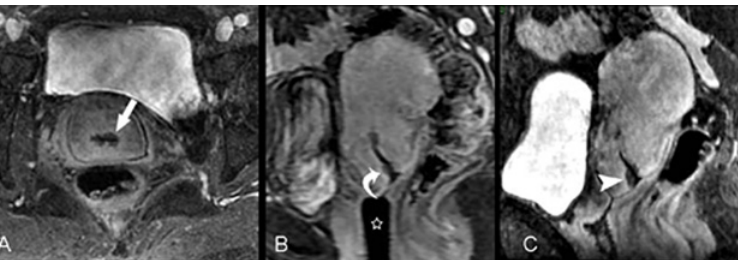
Fig 2. F48, poorly differentiated squamous cell carcinoma (stage IB1). Contrast-enhanced axial isotropic sequence (A) shows a low signal lesion around the cervical canal (arrow); the signal is lower than that of the surrounding cervical stroma and the greatest depth is approximately 4.4 mm. Directly acquired contrast- enhanced sagittal images (B) show a suspicious low signal lesion in the cervical canal close to the external os of the uterus (curved arrow). An OB tampons was placed inside the vagina (star). Oblique sagittal images reconstructed by the Isotropy (C) reveal the boundary of the cervical lesion (arrow head) more clearly, improving diagnostic confidence.